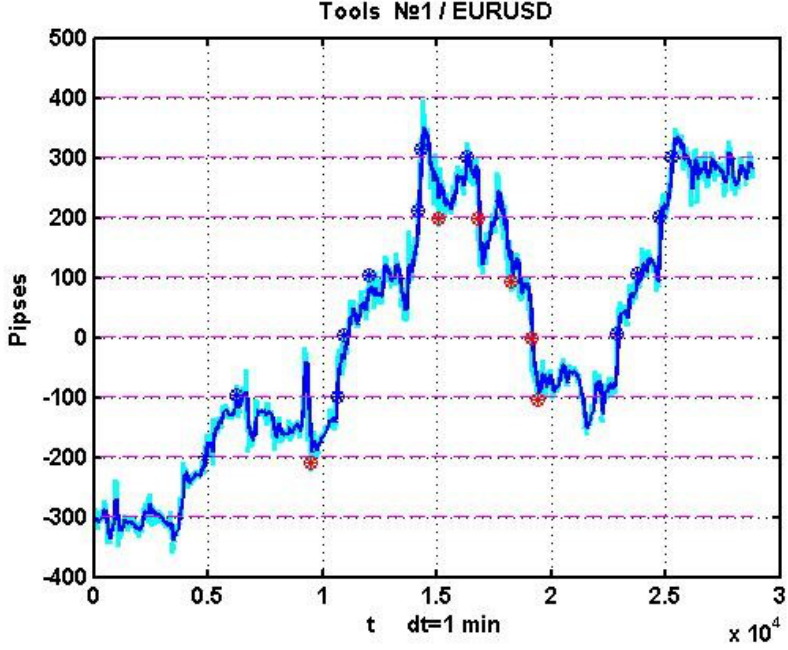
Figure 2. An example of EURUSD quotation dynamics on a 10-day observation